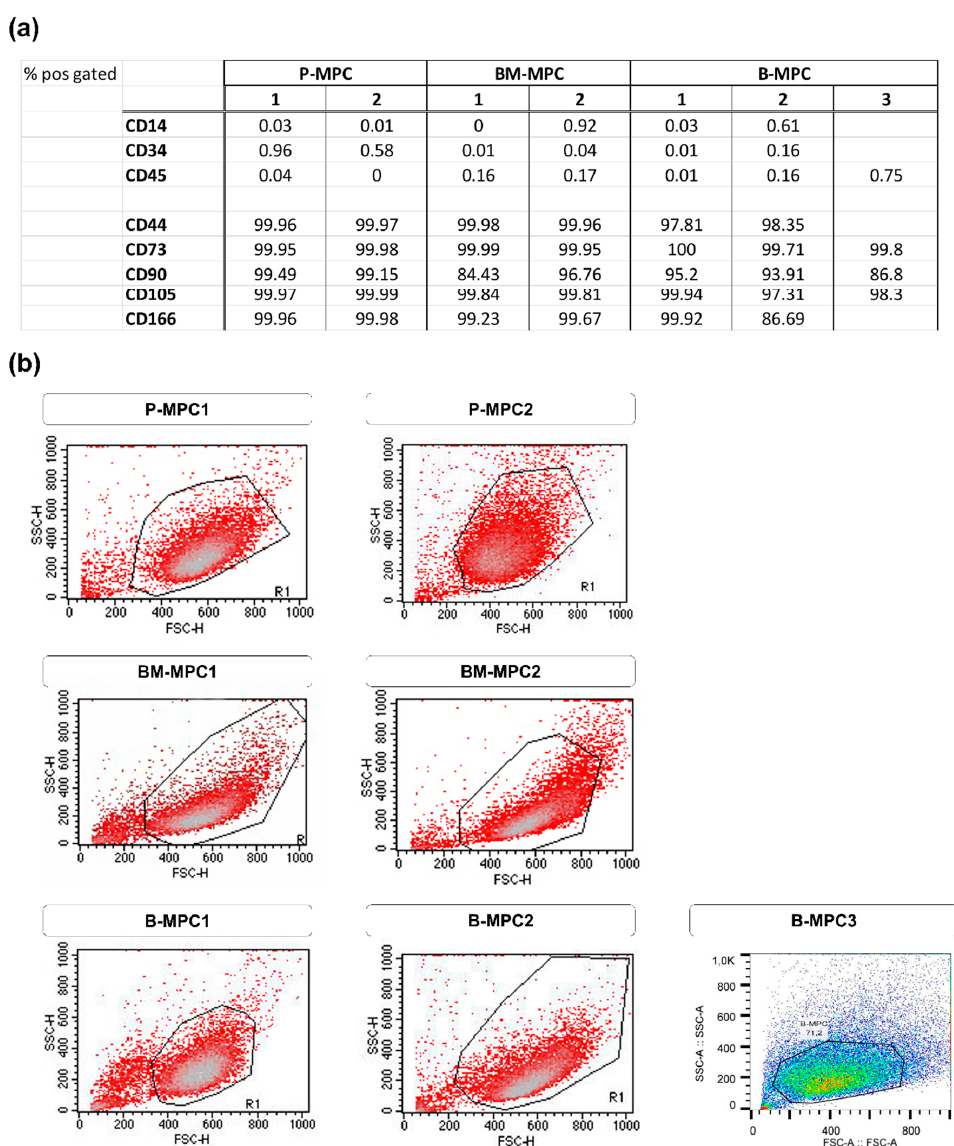
Figure A3. Flowcytometrical analyses of MPCs. ( a ) Results from flowcytometrical analyses of cell surface antigen patterns of isolated MPCs. ( b ) Side versus forward scatter density plots of analyzed MPCs.